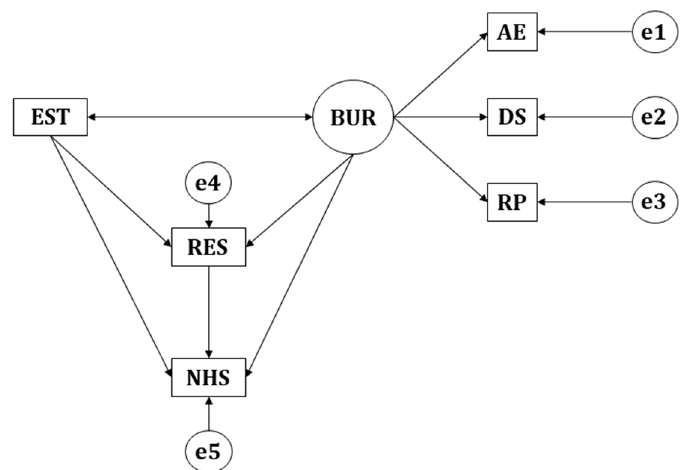
Figure 1. Proposed Theoretical Model. Note: Stress (EST); Resilience (RES); Burnout Syndrome (BUR); Emotional Exhaustion (EE); Depersonalisation (DS); Number of Study Hours (NHS); Personal Accomplishment (PR).